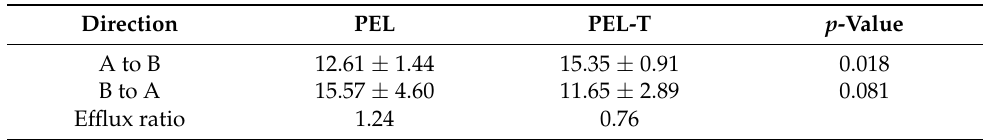
Table 3. The permeability coefficients (K p ) of PEL and PEL-T in the absorptive [A to B] and secretory [B to A] directions, and the efflux ratio across the Caco-2 cell monolayers. Direction PEL PEL-T p -Value A to B 12.61 ± 1.44 B to A 1.24 0.76 Each value is represented as the mean ± S.D. ( n = 5); K p (cm/h); A, apical; B, basolateral.